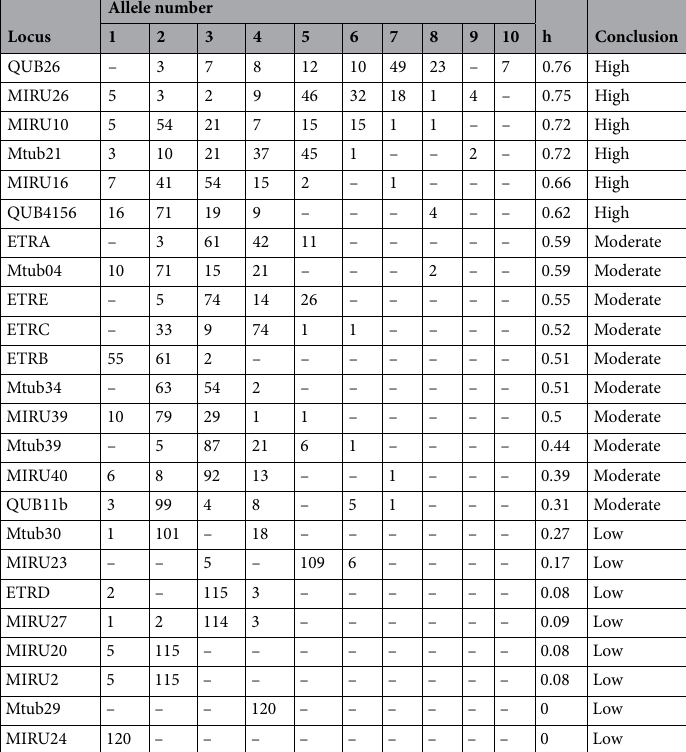
Table 1. Allelic diversity for each locus for Mycobacterium tuberculosis